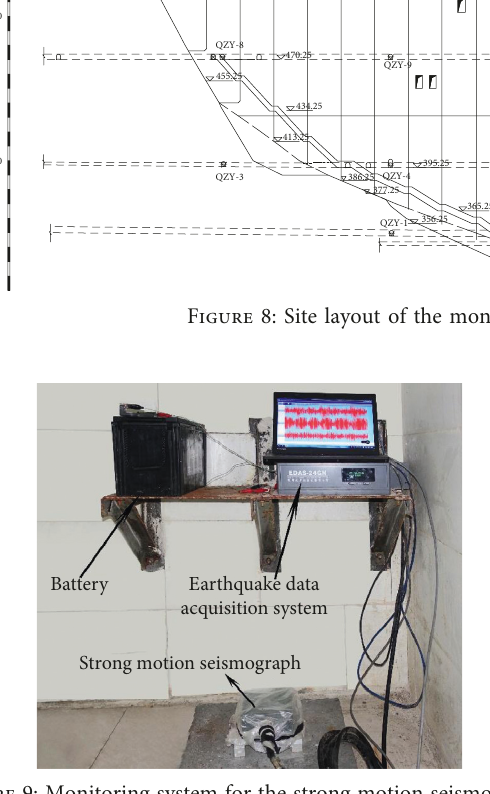
Figure 9: Monitoring system for the strong motion seismograph.